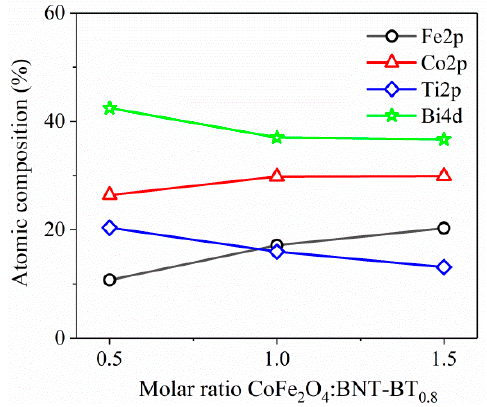
Figure 7. The atomic composition, determined from core levels photoemission of Fe 2p, Co 2p, Ti 2p and Bi 4d, for the samples S 1 – S 3 .